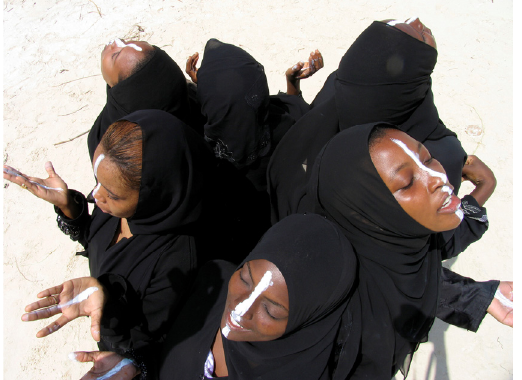
Figure 6. Maïmouna Guerresi, Dikhr , 2007. Video. 5:34 min. © Maïmouna Guerresi, courtesy Mariane Ibrahim Gallery.